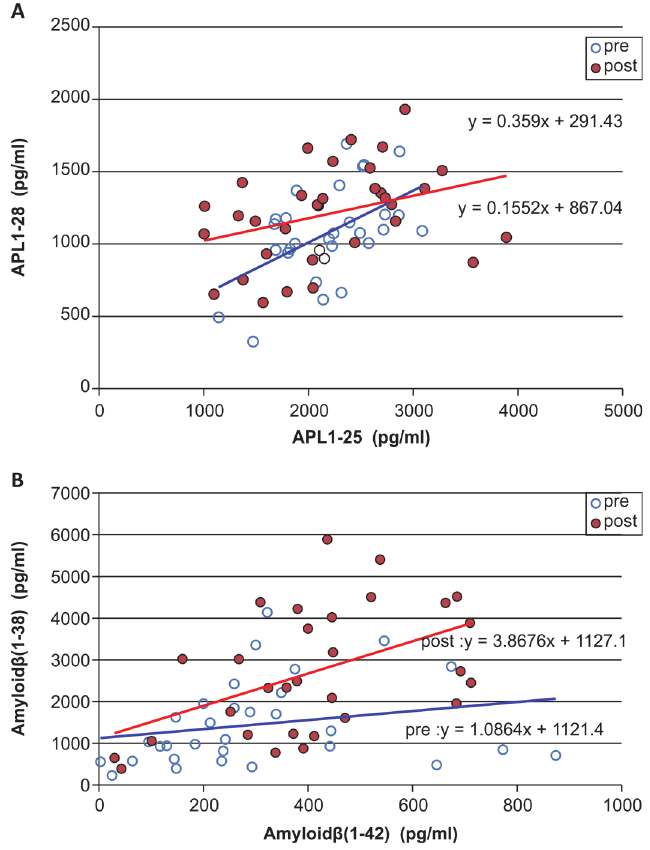
Fig 4. Association of Alzheimer ’ s disease-related proteins before and after shunting. A: Association between APL1 β 25 and APL1 β 28. B: Association between A β 38 and A β 42. Abbreviations: pre, before lumboperitoneal shunt; post, after lumboperitoneal shunt; A β , amyloid β -peptide; APL1 β , APLP1-derived A β like peptide.